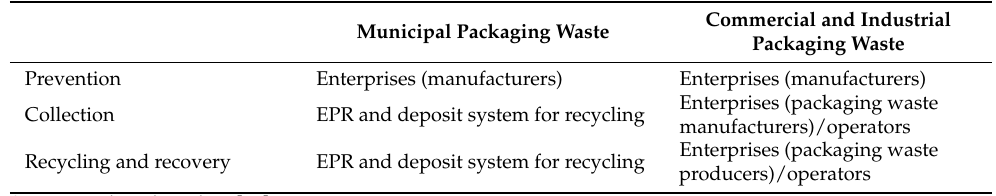
Table 1. Responsibilities for prevention, collection, recycling, and recovery in Germany.